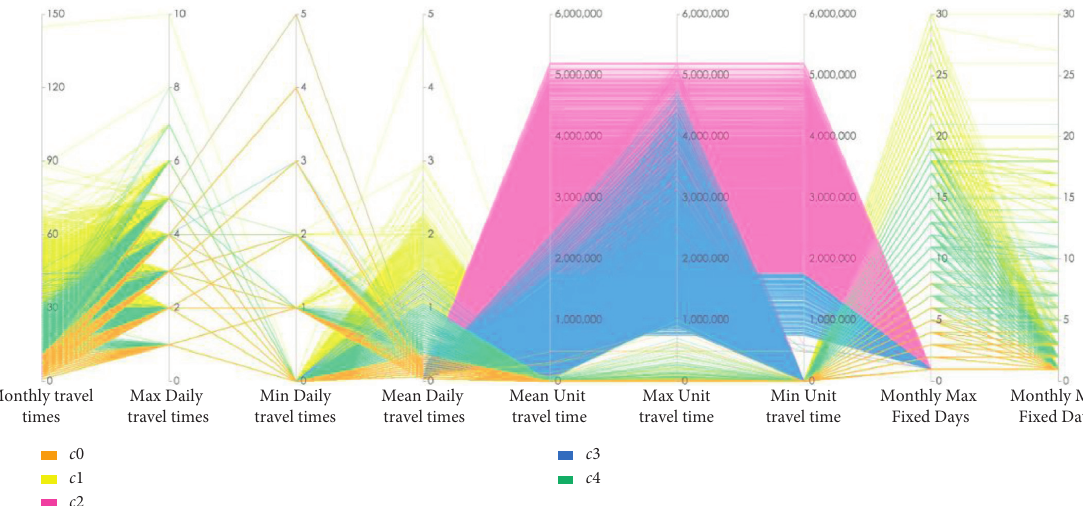
Figure 8: Statistical distribution of travel features describing travel dependency